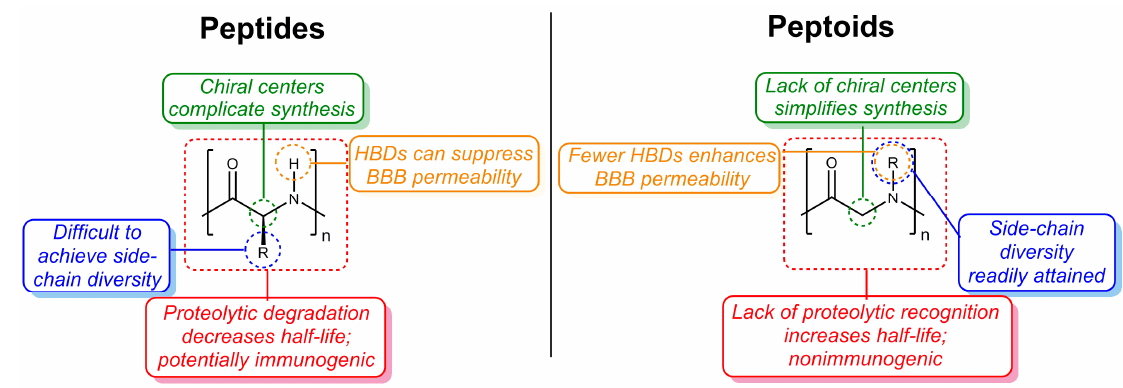
Figure 1. Summary of advantages of peptoids over peptides.